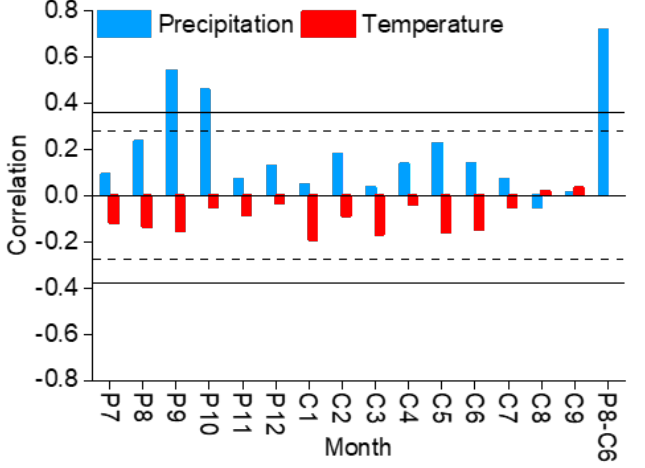
Figure 4. Correlation analyses between the residual chronology and monthly total precipitation and average temperature during 1958–2013. “P” and “C” represent the previous year and the current year, respectively, and the solid and dashed lines represent the 99% and 95% confidence level, respectively.